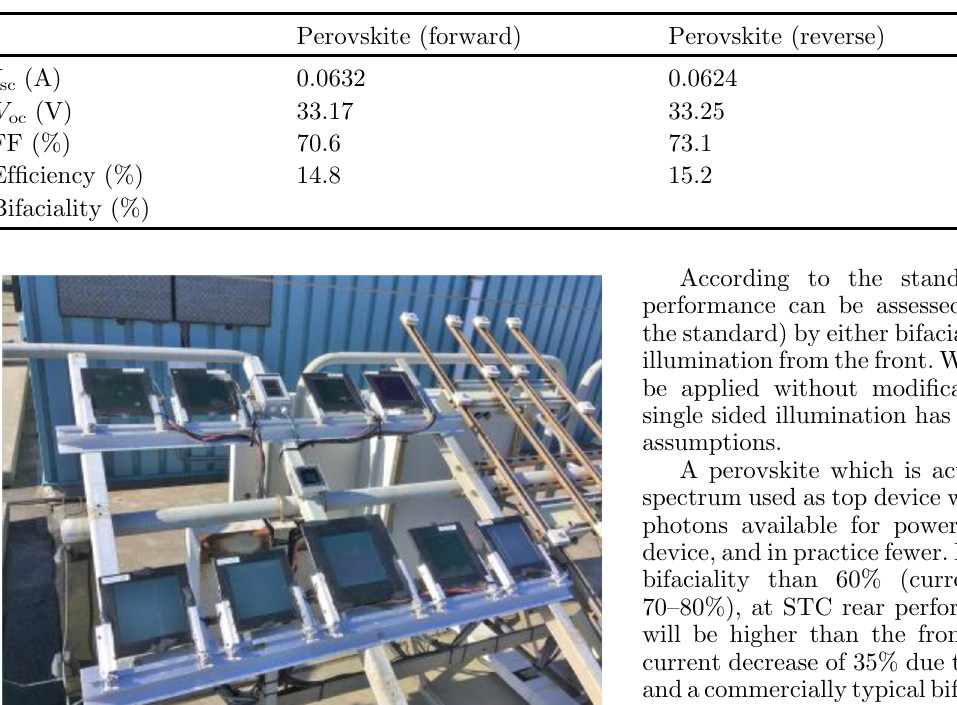
Table 1. Device parameters of the components of the 4T tandem devices. All devices are 100 cm 2 at the time of measurement.